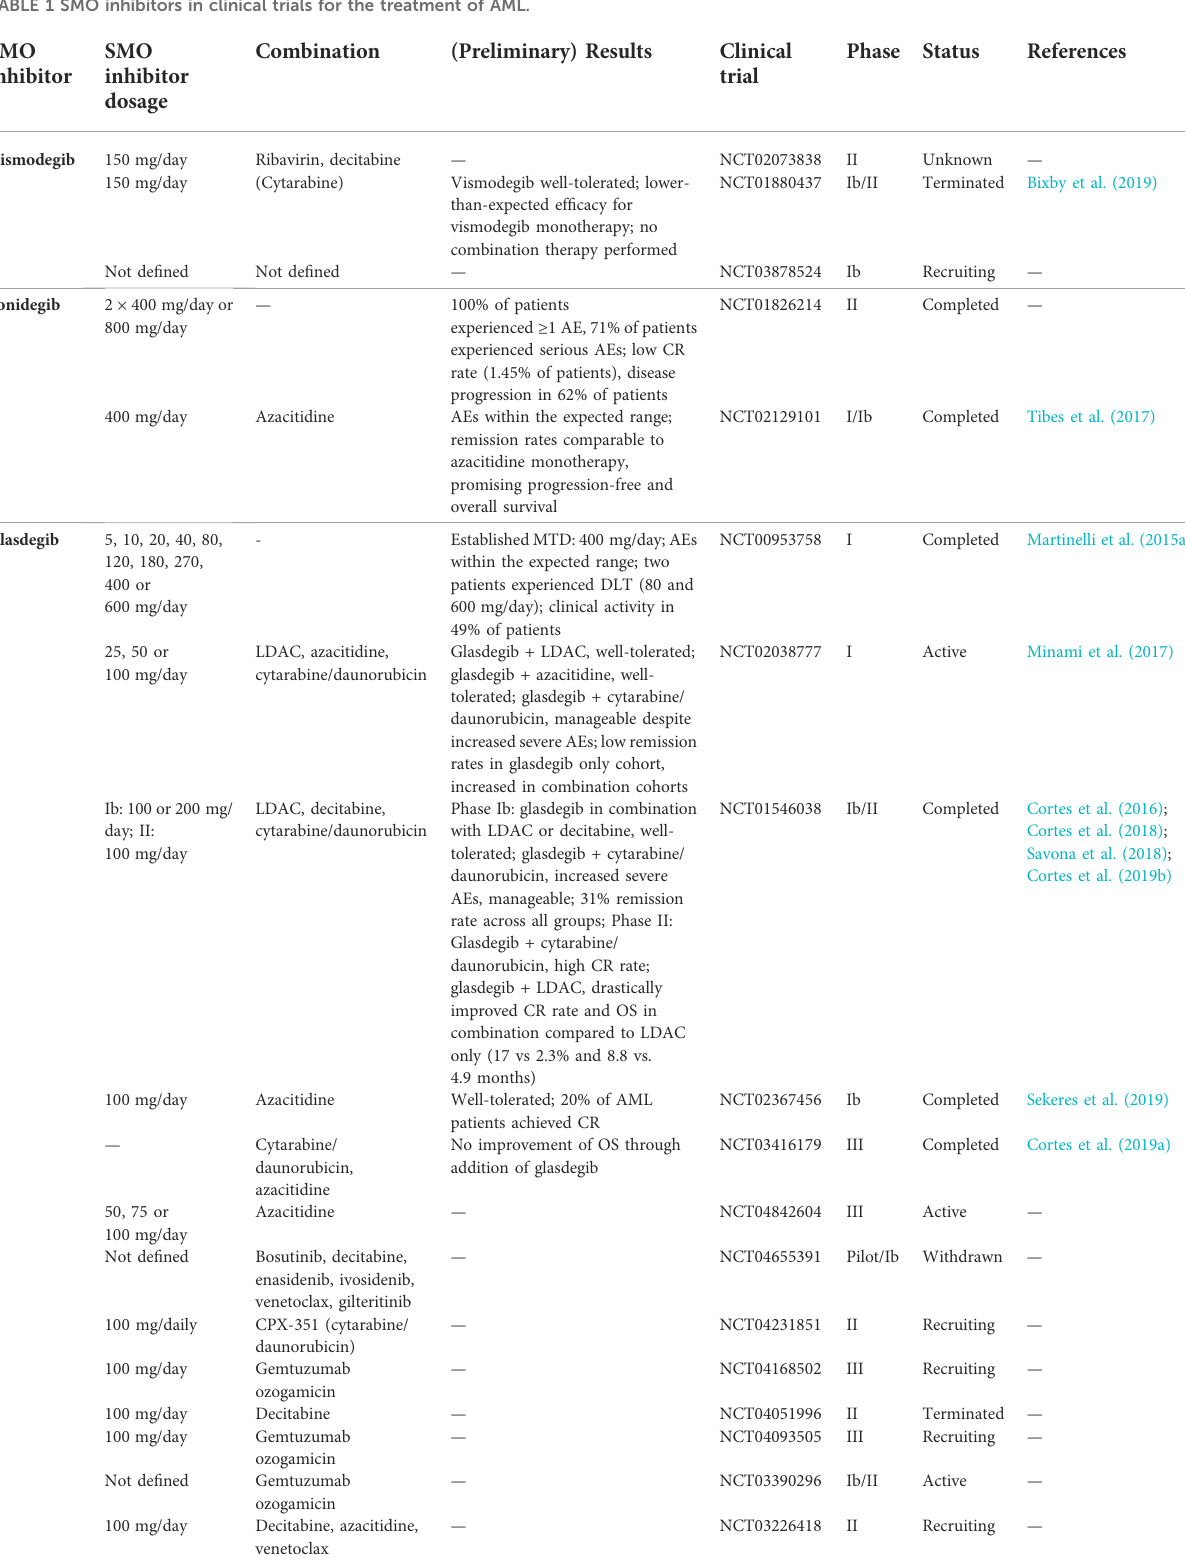
TABLE 1 SMO inhibitors in clinical trials for the treatment of